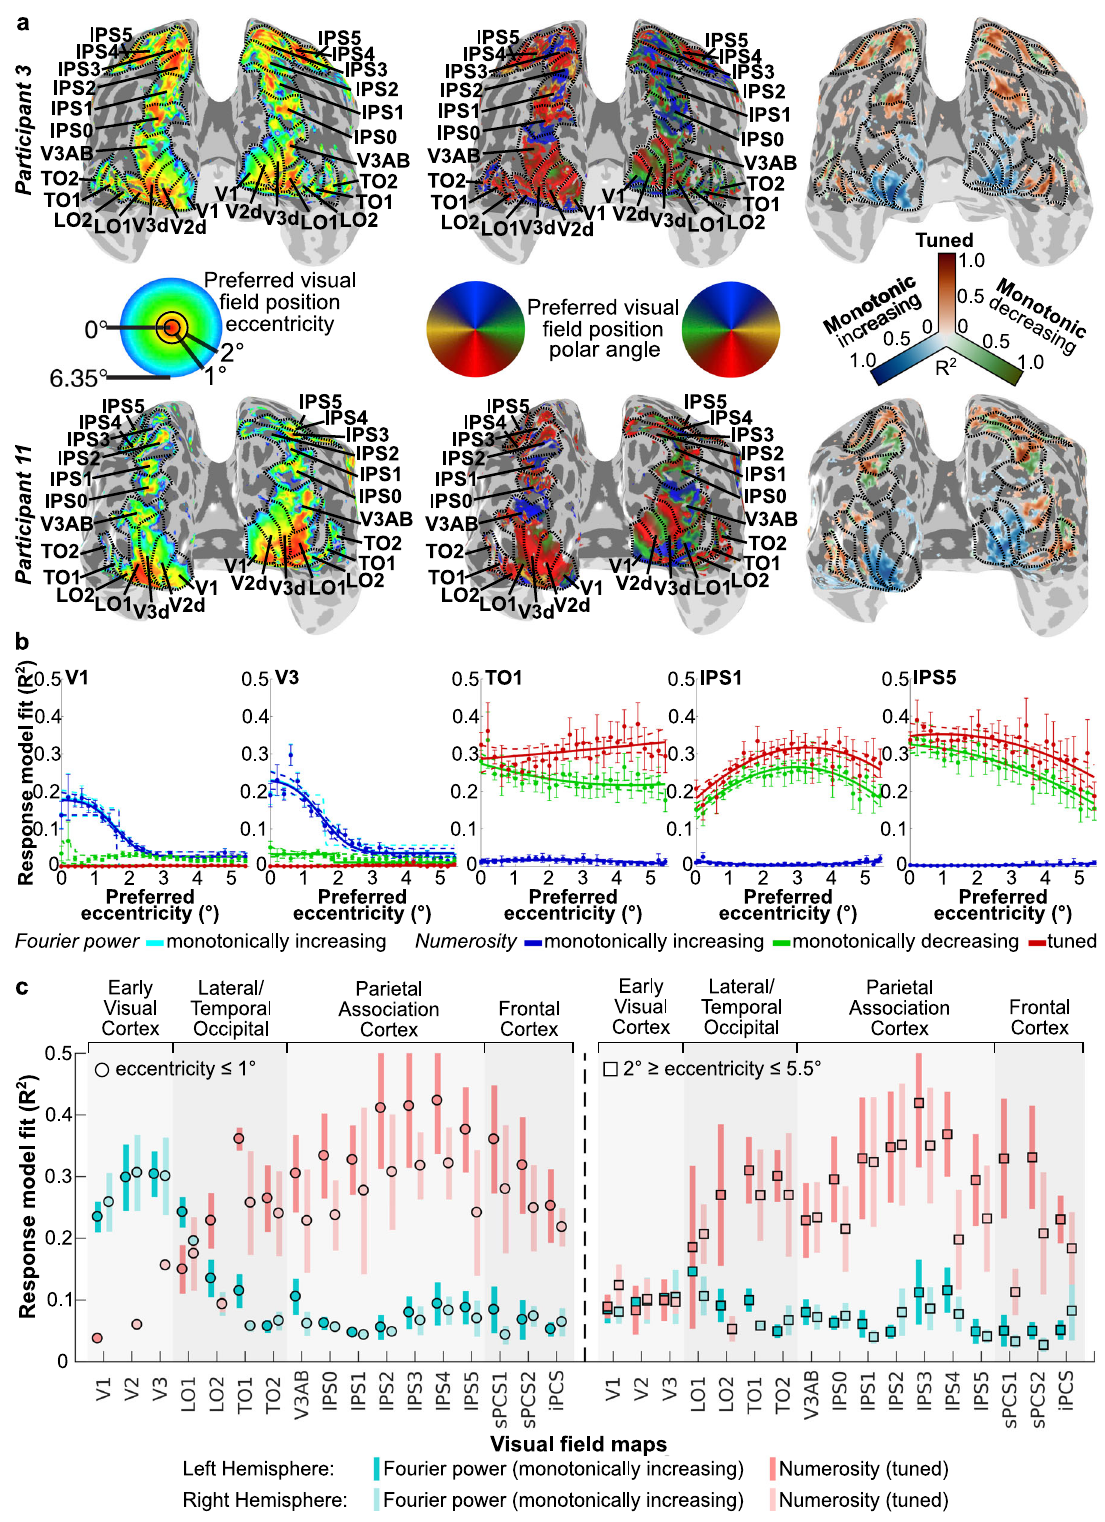
power across all stimulus con fi gurations (Median difference = 0.0104, Z = − 3.32, p < 0.001) (Fig. 5b), as previously shown for other non-numerical features 17,18 . Numerosity-tuned models also fi t better within each stimulus con fi guration, though this difference is not signi fi cant in the high-density con fi guration ( Z = − 1.46, p = 0.1454, FDR corrected for the comparisons in different stimulus con fi gurations) (Fig.